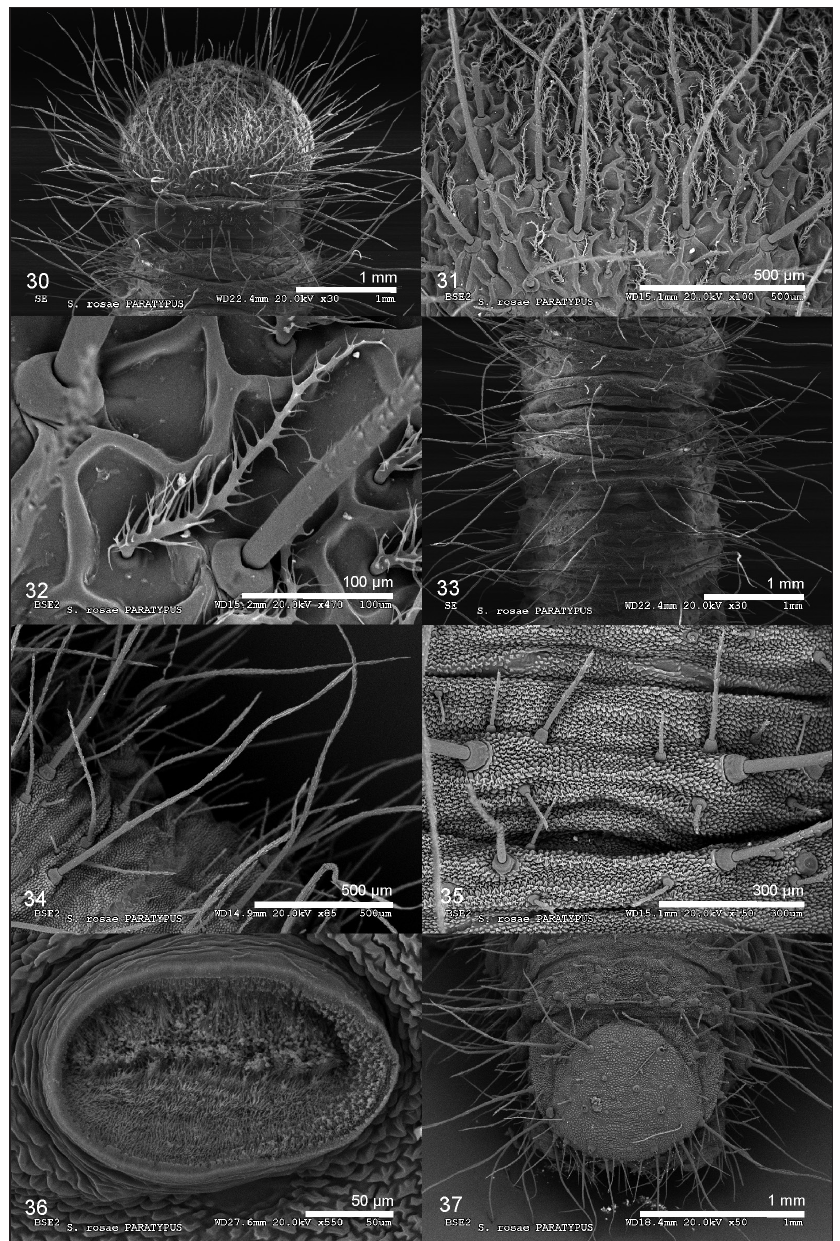
Figures 30–37. Scanning electron microscope images of a last instar larva of Spialia rosae (Paratype from Sierra de Albarracín, Teruel, Central Spain). 30. Head capsule and collar. 31, 32. Detail of the head capsule setae and sculpture. 33. Cuticular formations on thoracic and abdominal segments. 34. Detail with different types of subdorsal and lateral setae on the first thoracic segment: long and short setae with pointed tips. 35. Cuticular formations on an abdominal segment. 36. Last abdominal spiracle. 37. Last abdominal segments with the anal plate and setae with pointed tips and rounded